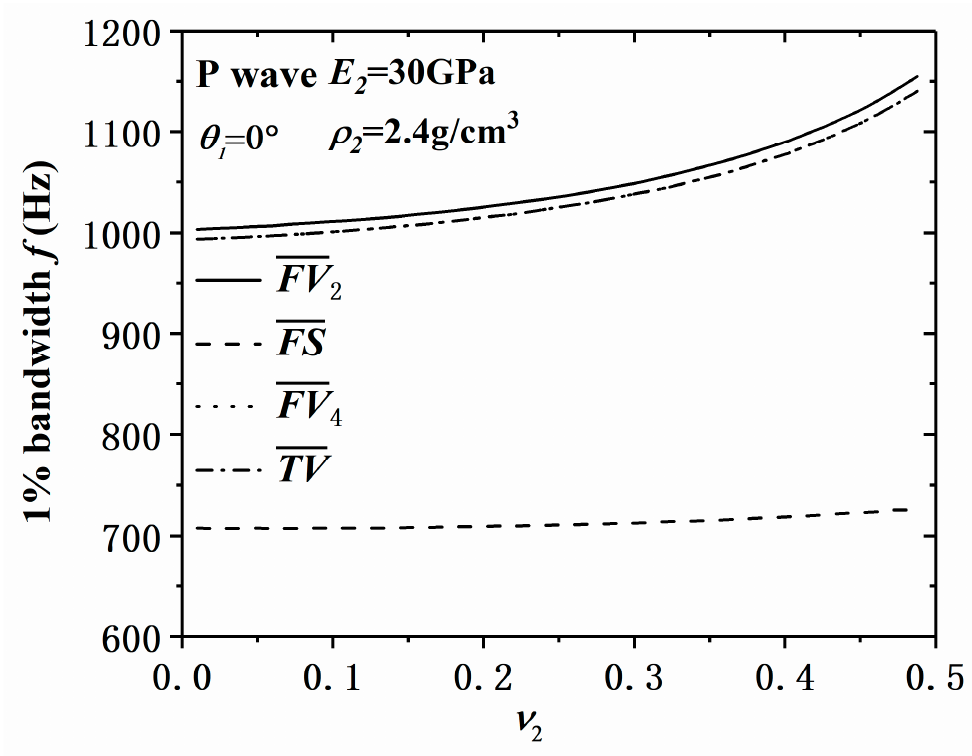
Figure 10. The influence of the Poisson ratio ν 2 of the expansive grout on 1% bandwidth of FV 2 , FV 4 , TV and FS for borehole tensor strainmeters for the incident P wave. Table 9. 1% bandwidth of gauge combinations for different mechanical parameters of the expansive grout by incident P/S wave.